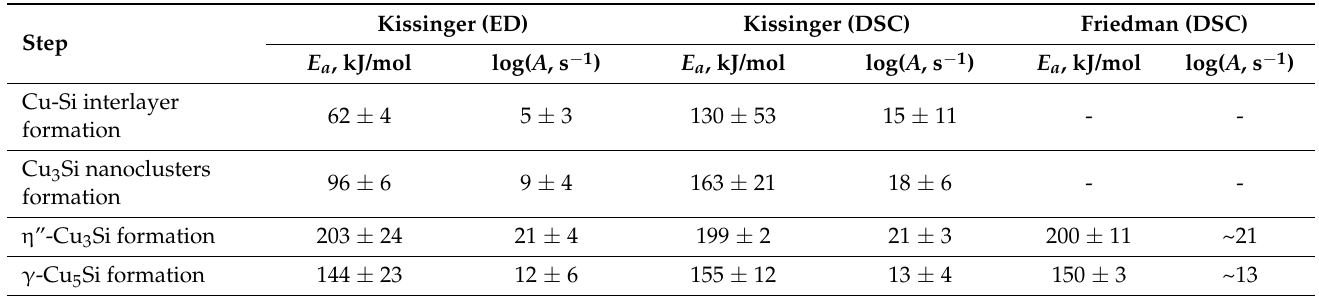
Table 6. Model-free estimation of the kinetic parameters of the solid-state transformation process in the Cu/a-Si thin films obtained using the DSC and electron diffraction data.